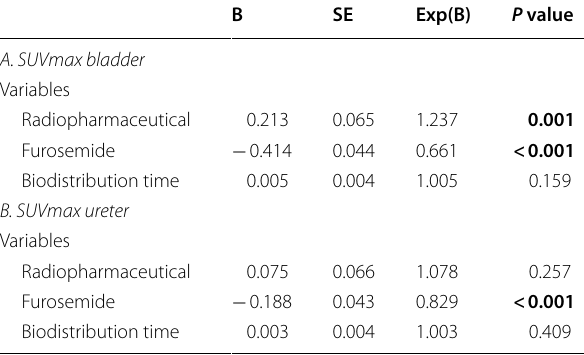
Bold values are significant B, b-coefficient; SE, standard error for b-coefficient; and Exp(B), exponentiated